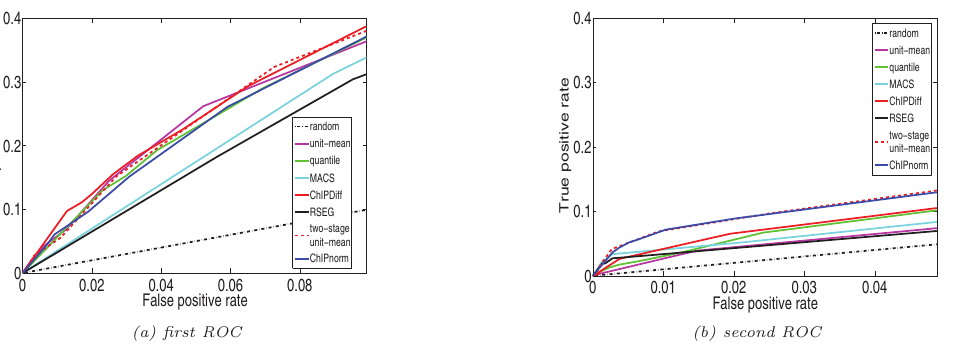
Figure 9. Two ROC curves are shown for various methods. (a) first ROC: Class 1 – four-fold NP differentially over-expressed genes compared to ES; Class 0: rest of the genes. (b) second ROC: Class 1 – four-fold ES differentially over-expressed genes compared to NP; Class 0: rest of the genes.